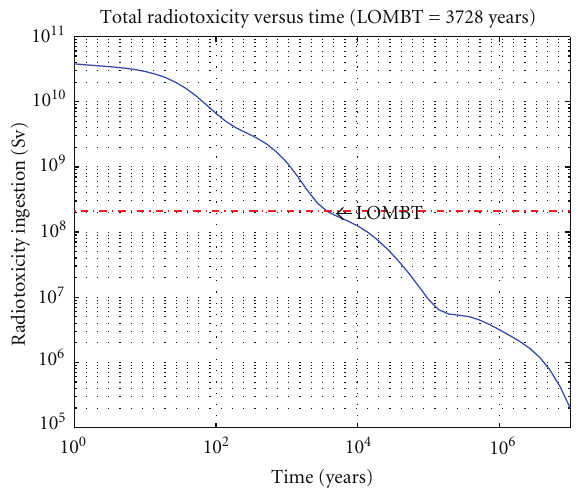
Figure 17: LOMBT of GCFR SNF end sixth cycle (FPs, Am, and